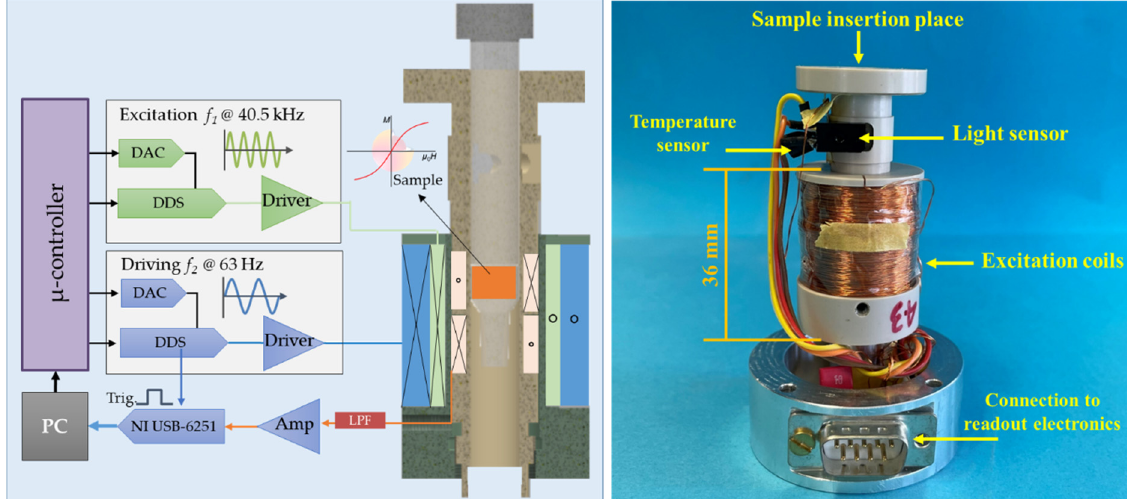
Figure 1. ( Left ) Schematic block diagram of the excitation and readout circuitry connected to the cross-sectional view of the measurement head assembly. ( Right ) Photo of the internal configuration of the measurement head and the high- and low-frequency excitation coils around the detection coils. The sample is inserted into the measurement head from above, and a light sensor is used to monitor the insertion and removal of the sample.